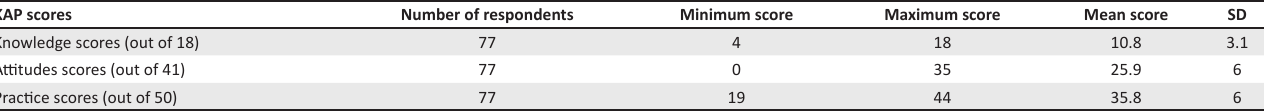
TABLE 3: Overall KAP